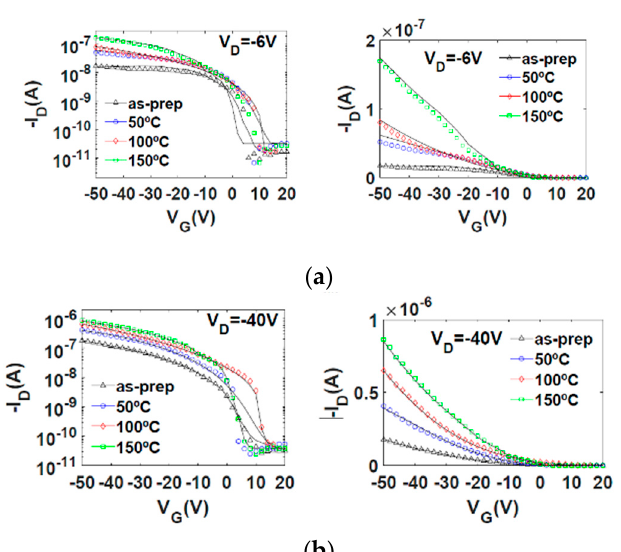
Figure 5. Comparison of experimental (symbols) and calculated (solid lines) transfer characteristics at di ff erent drain voltages V D in NiPc 6 OTFTs annealed at di ff erent temperatures: ( a ) V D = − 6 V; ( b ) V D = − 40 V. Note that the left side figures contain the same I D values as the right side figures, but with di ff erent scale (logarithmic and